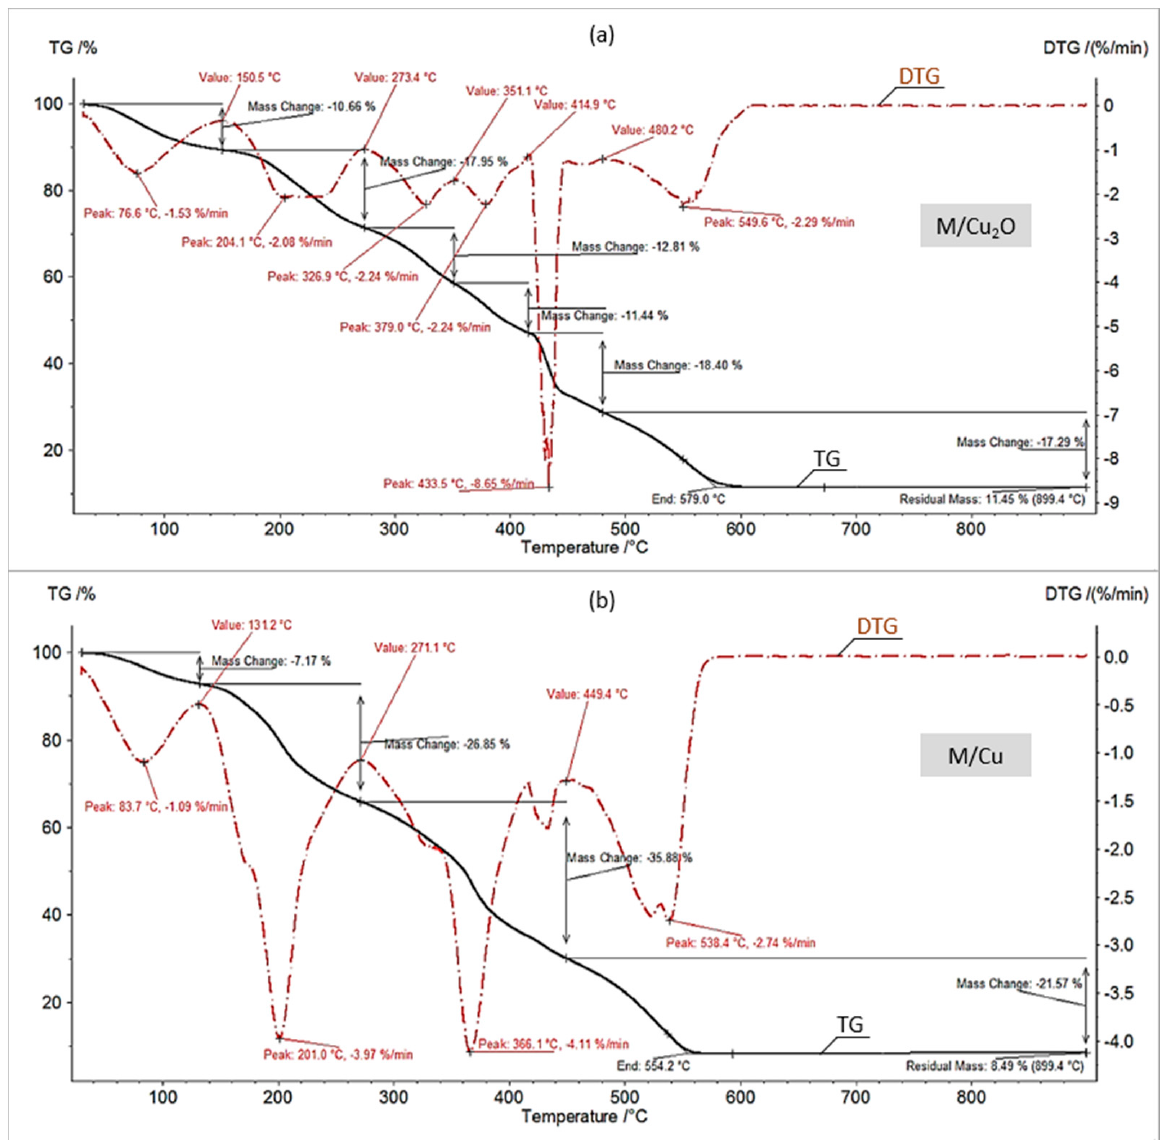
Figure 1. Thermogravimetry (TG)//derivative thermogravimetry (DTG) curves in air of ( a ) M/Cu 2 O, ( b ) M/Cu.